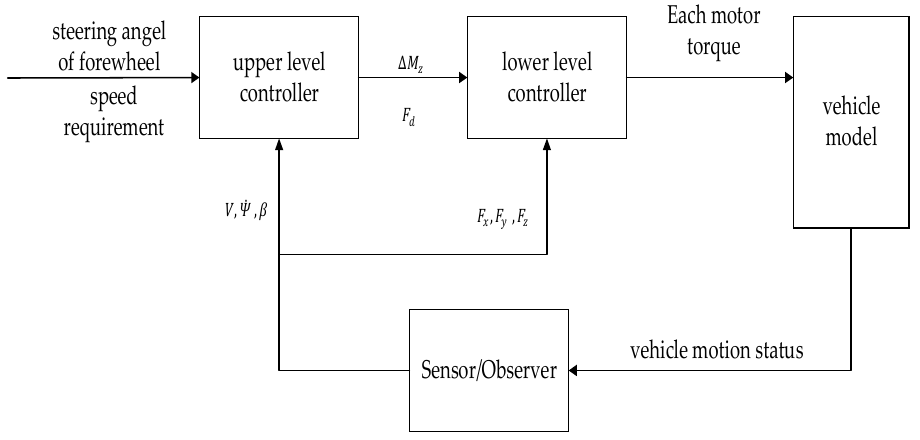
Figure 4. Frame design for vehicle yaw moment control.